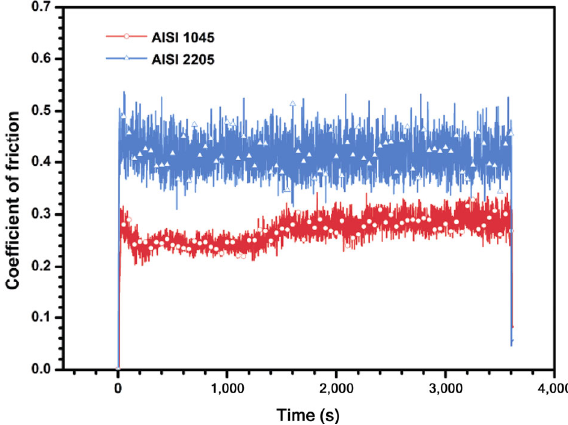
Fig. 8 Dynamic coefficient of friction measured during sliding tests in